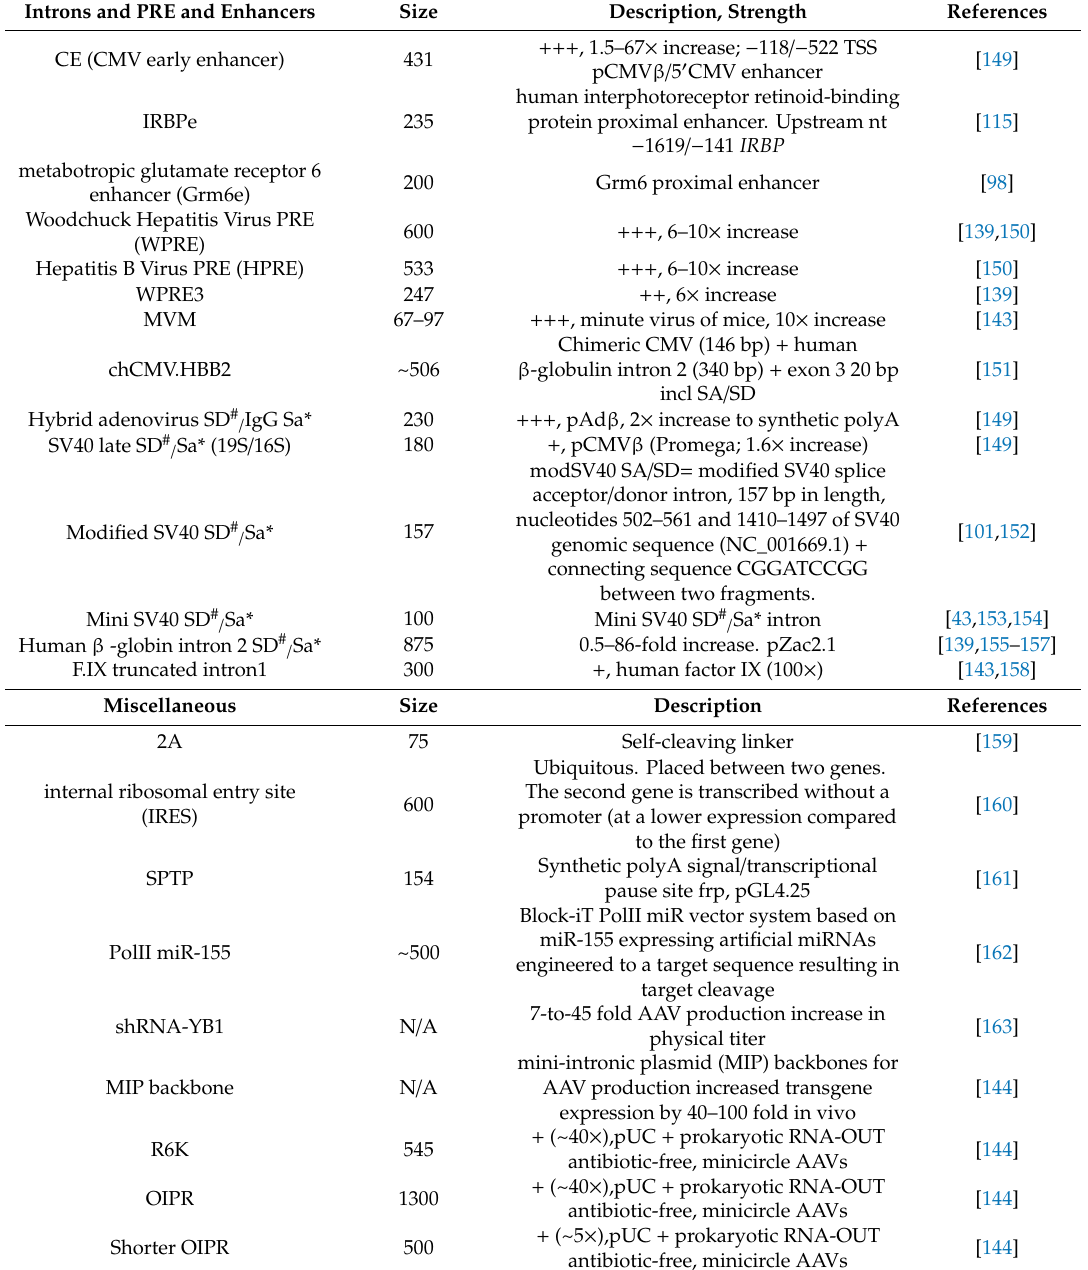
Table 4. Other elements in rAAV vectors: A. Introns, PRE, and enhancers. B. Miscellaneous. Introns and PRE and